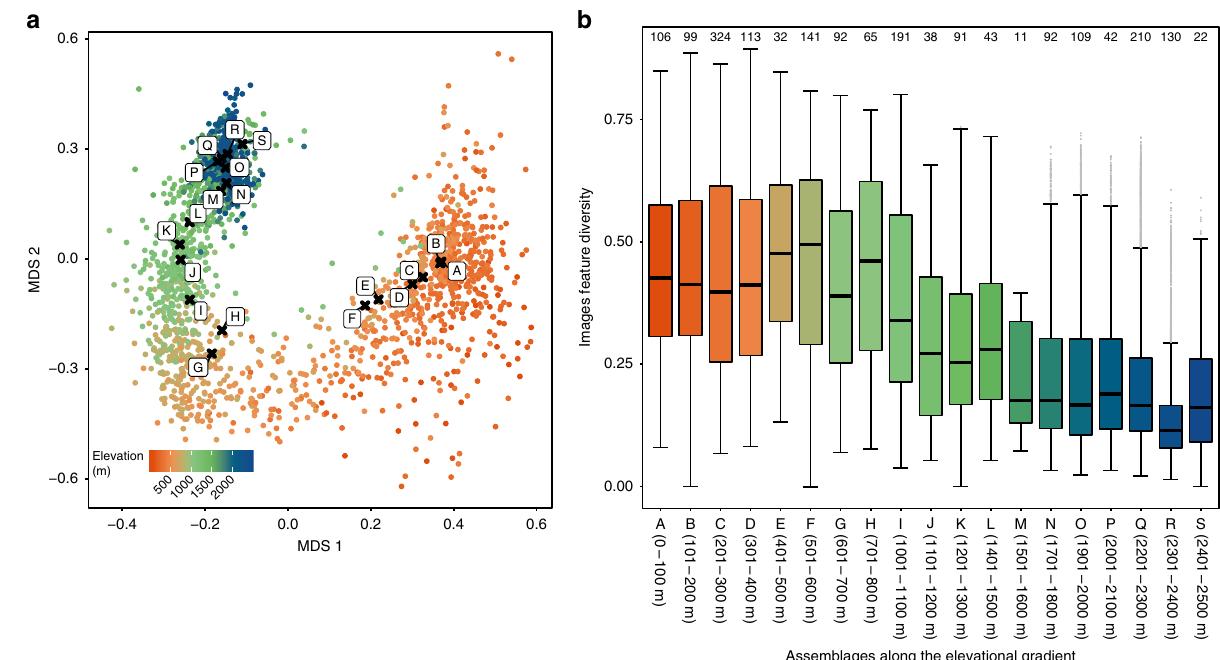
Fig. 3 Multidimensional scaling (MDS) visualization of image features and within-assemblage image feature diversity of moths. a An MDS visualization of the 2048-dimension feature vector of species in relation to the moths ’ elevational distribution. b Species assemblages along the elevational gradient were determined by their mean elevation. The legend of 0 – 100 m represents the assemblage of species mean elevations range from 0 to 100 m above sea level and so on, until 2400 to 2500 m. Since some intervals have no collection event, we acquired 19 species assemblages in total. Within-assemblage image feature diversity was de fi ned as the cosine distance of their 2048-dimension feature vectors between any two species within the same assemblage. Warmer colours correspond to lower elevations, and cooler colours to higher elevations. In box-and-whiskers diagrams, boxes indicate median and upper and lower quartile and whiskers indicate range of data. Source data are provided as a Source Data fi